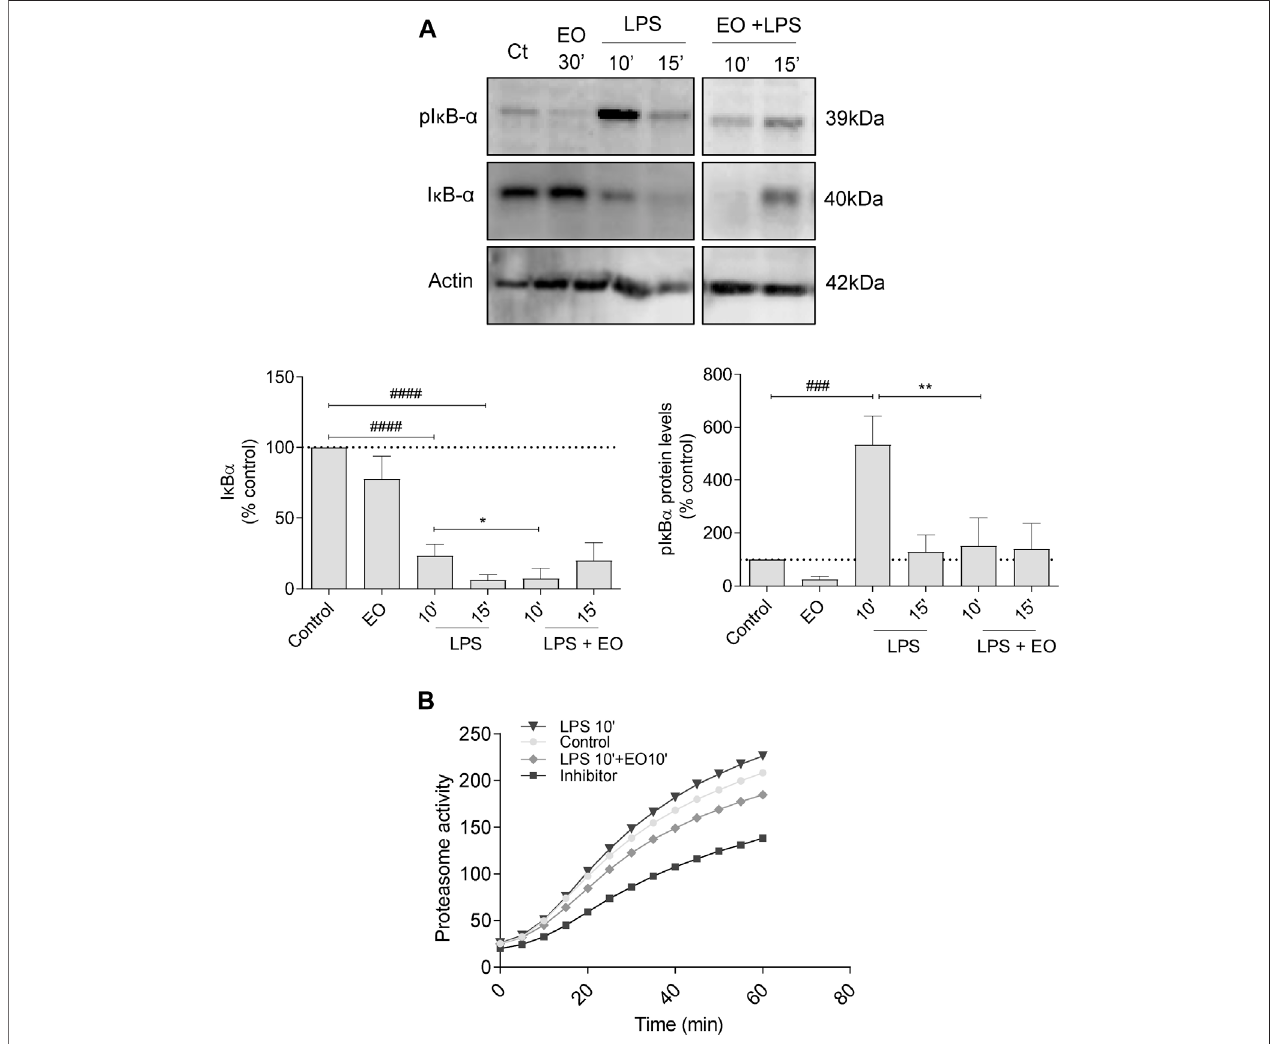
FIGURE 4 | Effect of L. viridis L´Hér. essential oil (EO) on the proteolytic degradation of I κ B- α : (A) Protein expression of pI κ B- α and I κ B- α . Raw 264.7 cells were maintained in culture medium (control), or incubated with LPS, or the EO (0.64 μ L/mL) alone for 30 min, or simultaneously with LPS and the EO for 10 or 15 min. (B) Effect of L. viridis L´Hér. essential oil on proteasome activity. Raw 264.7 cells were maintained in culture medium (control), or incubated with proteasome inhibitor MG- 132,ortheEOadded10 minpriortoreading.Eachvaluerepresentsthemean ± SEMfromatleastthreeexperiments,performedinduplicate.Statisticaldifferences between control and LPS groups were calculated using two-sided unpaired t -test and differences between a treatment condition and LPS alone was performed using one-way ANOVA followed by Dunnet ’ s post hoc test (### p < 0.001, #### p < 0.0001, compared to control; * p < 0.05, ** p < 0.01, compared to LPS 10 min).